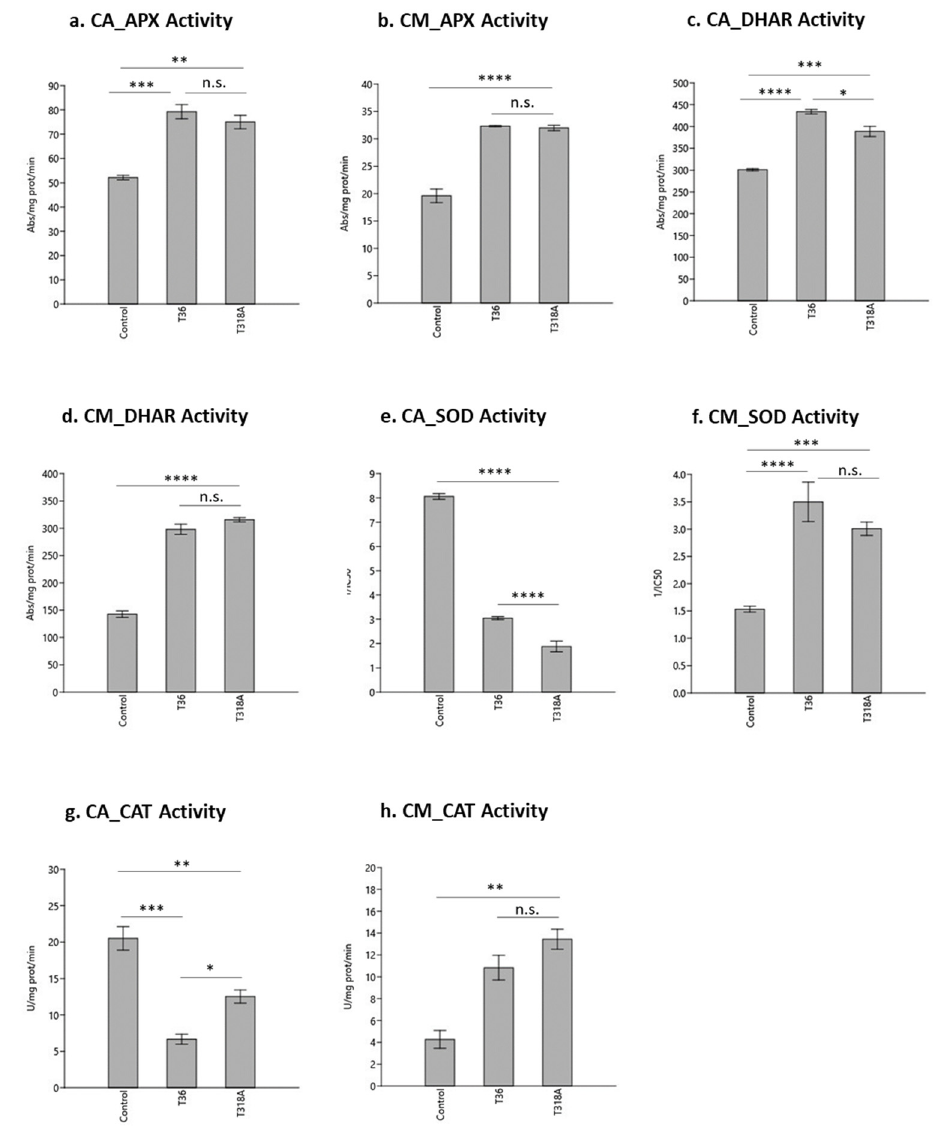
Figure 1. Activity of antioxidant enzymes in the phloem sap of sour orange and alemow, healthy and infected with CTV T36 isolate or T318A. Comparisons were made between control and infected samples and between the infected samples. ( a ) ascorbate peroxidase (APX) activity in CA; ( b ) APX activity in CM; ( c ) dehydroascorbate reductase (DHAR) activity in CA; ( d ) DHAR activity in CM; ( e ) superoxide dismutase (SOD) activity in CA 1/IC50; ( f ) SOD activity in CM 1/IC50; ( g ) catalase (CAT) activity in CA; ( h ) CAT activity in CM. ****: p < 0.0001; ***: p < 0.001; **: p < 0.01; *: p < 0.05; n.s.: not signi fi cant ( p > 0.05).